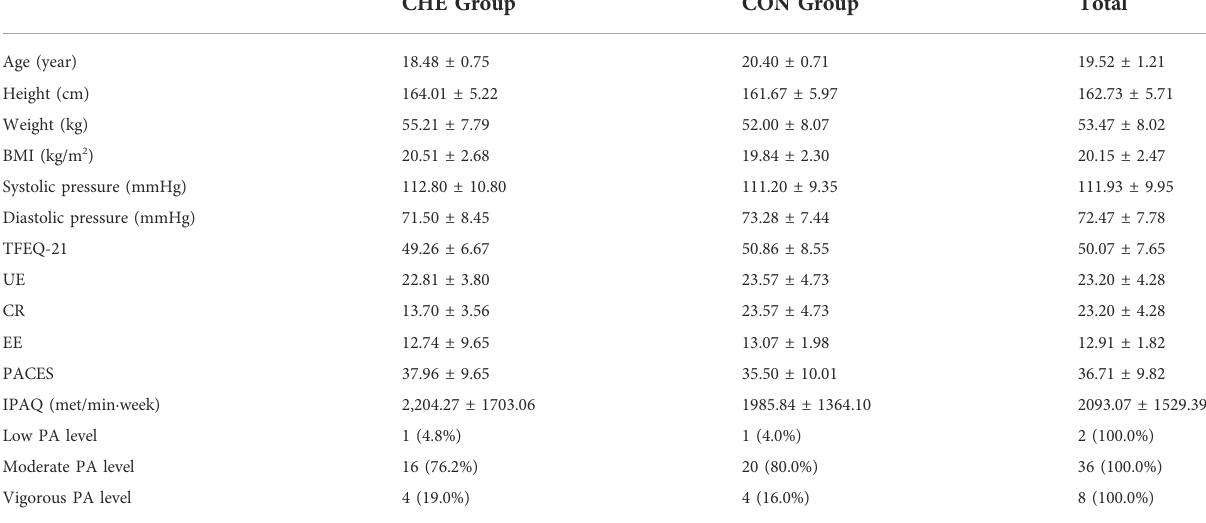
TABLE 2 Basic participant characteristics (mean ± SD).